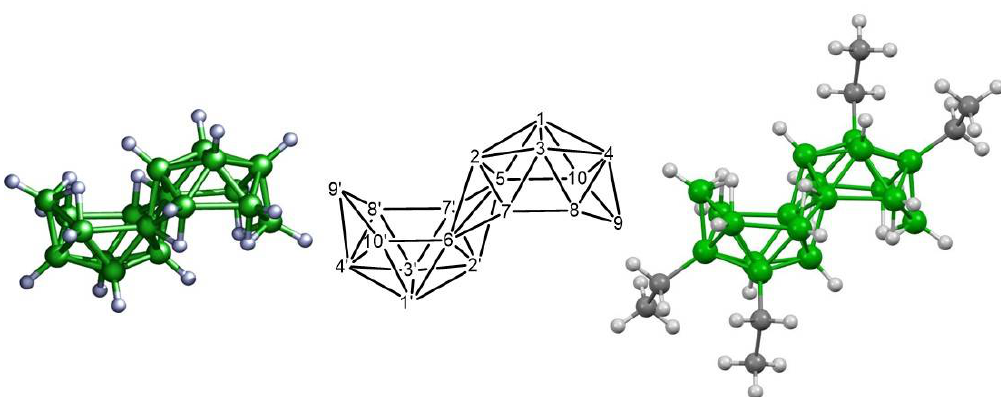
Figure 1. The molecular structure of 3,3′,4,4′-Et 4 - anti -B 18 H 18 (compound 2 , right) [19]. In anti -B 18 H 22 (compound 1 , left), the ethyl group positions are occupied by hydrogen atoms. The numbering system for the boron cluster is shown in the centre.